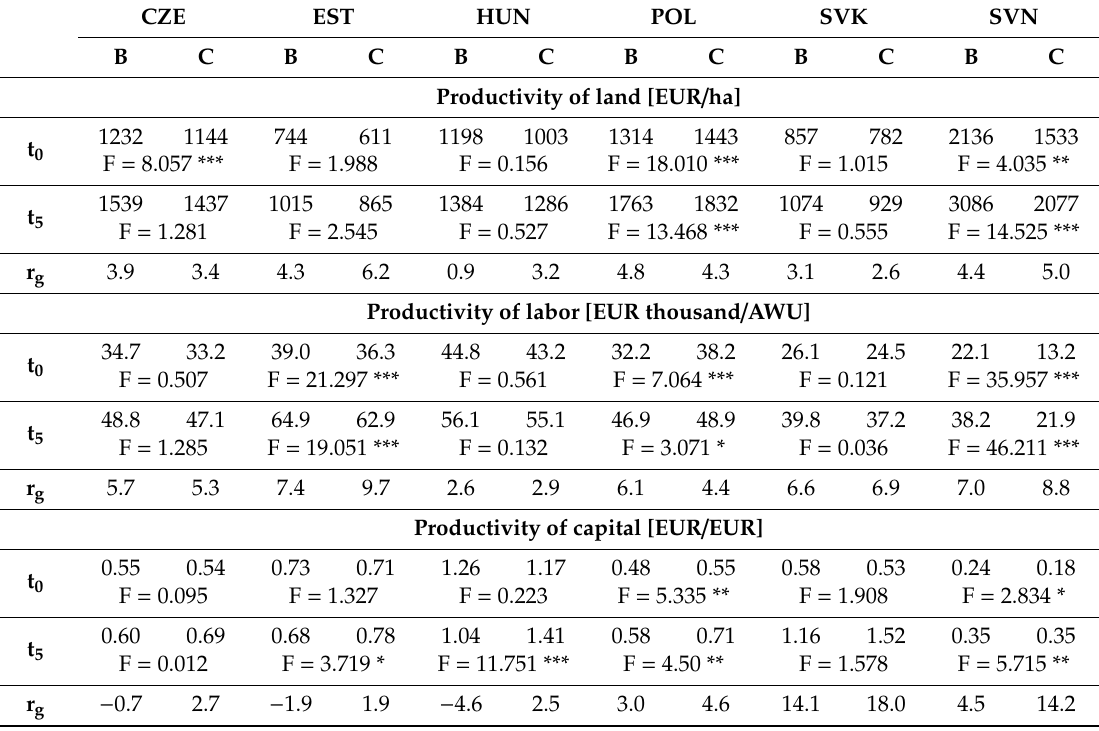
Table 6. Productivity of productive input (measured as total output) of beneficiary farms which accessed pro-investment funds under the second pillar of the CAP and of control farms in the base year (preceding the year where the beneficiaries accessed the pro-investment mechanisms under the second pillar of the CAP) and in the fifth year after they accessed the respective